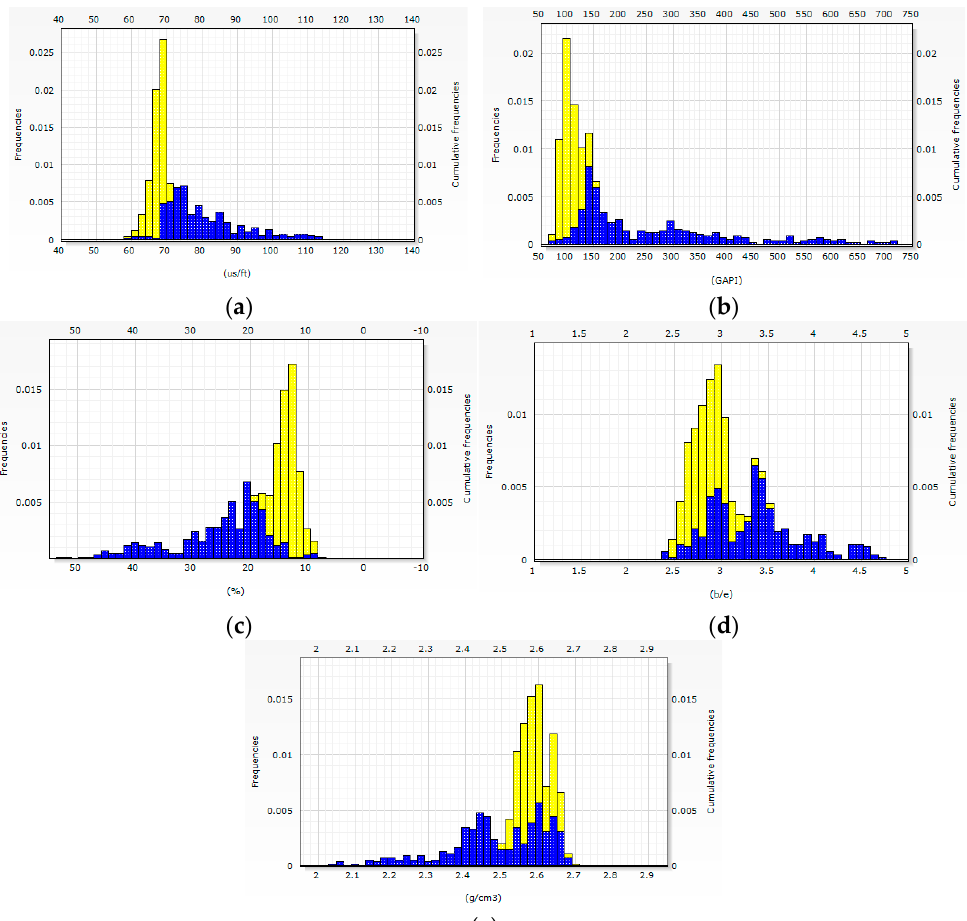
Figure 12. Different curve log response characteristics of shale and non-shale intervals. ( a ) Histogram of frequency distribution of AC curve; ( b ) Histogram of frequency distribution of GR curve; ( c ) Histogram of frequency distribution of CNL curve; ( d ) Histogram of frequency distribution of PE curve; ( e ) Histogram of frequency distribution of DEN curves.